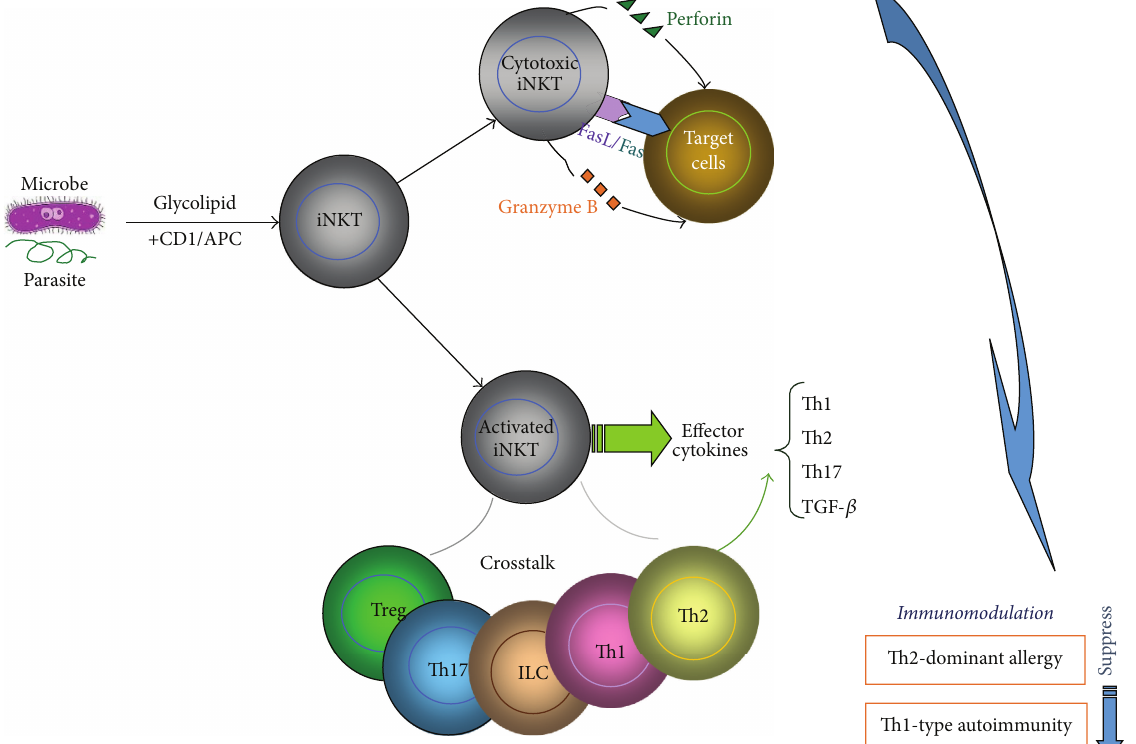
Figure 2: Diagram of iNKT cells in hygiene hypothesis. iNKT cells can be activated by glycolipids from microbes and parasites, which bind to CD1 molecules on antigen-presenting cell (APC). Activated iNKT cells secrete a broad range of effector cytokines. They also mediate cytotoxic activity, possibly involving both perforin/granzyme B and Fas/FasL pathways. Moreover, iNKT cells may cross talk with Treg, Th17, ILC, and Th1/2 subsets via secreted cytokines or direct contact. iNKT cells may exert their immunomodulatory effects in hygiene hypothesis through the above combined and other